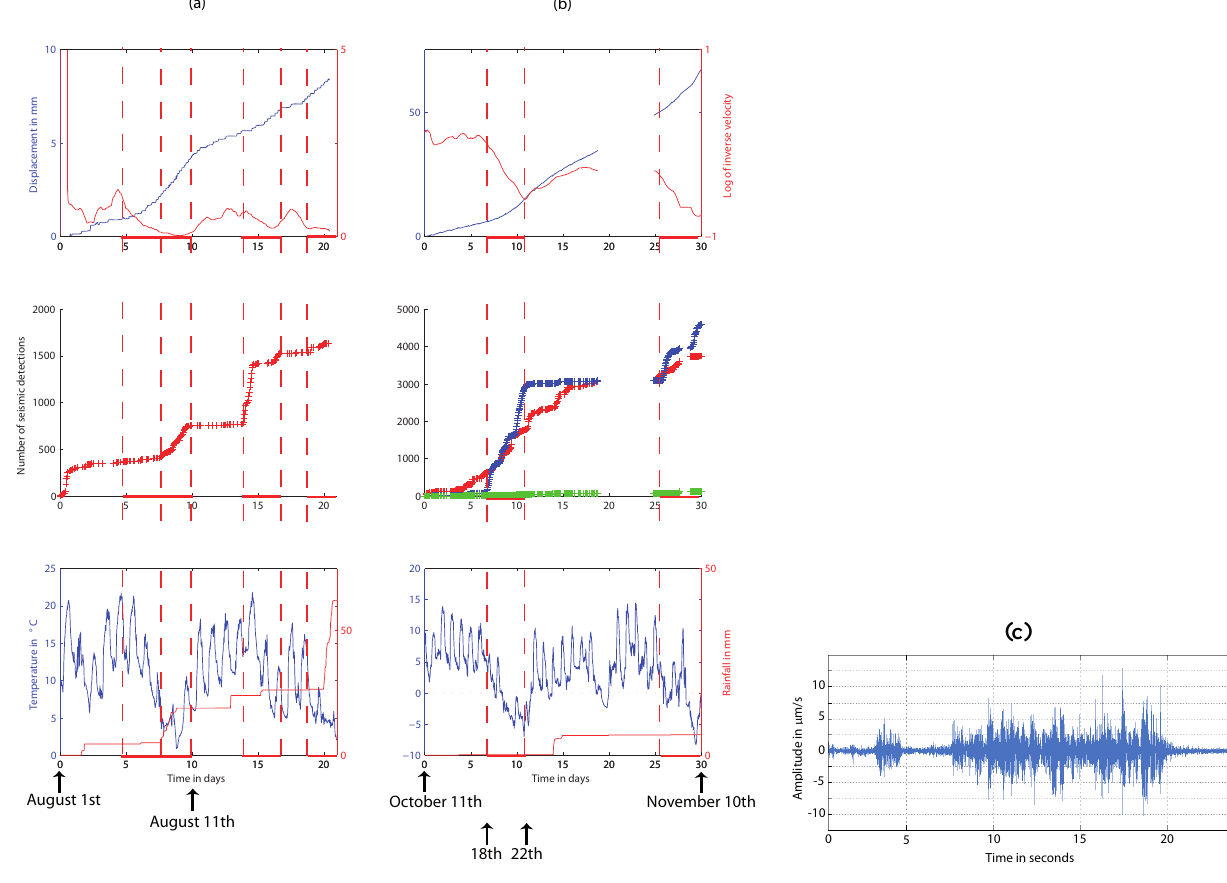
Figure 2c Fig. 2. Top: plot of displacement data (blue line: displacement measured by E1 extensometer, red line: log of inverse velocity); center: cumulated number of seismic detections (red crosses: vertical component of S1 geophone; blue crosses, S2 vertical geophone; green crosses: S3 vertical geophone); bottom: temperature (blue line) and rainfall (red line). (a) From 1 to 21 August; (b) from 11 October to 10 November. Red vertical dashed and horizontal thick lines represent the time periods during which average temperature drops, seismicity and displacement increase. (c) Plot of a typical seismic event occurring during a seismic crisis.